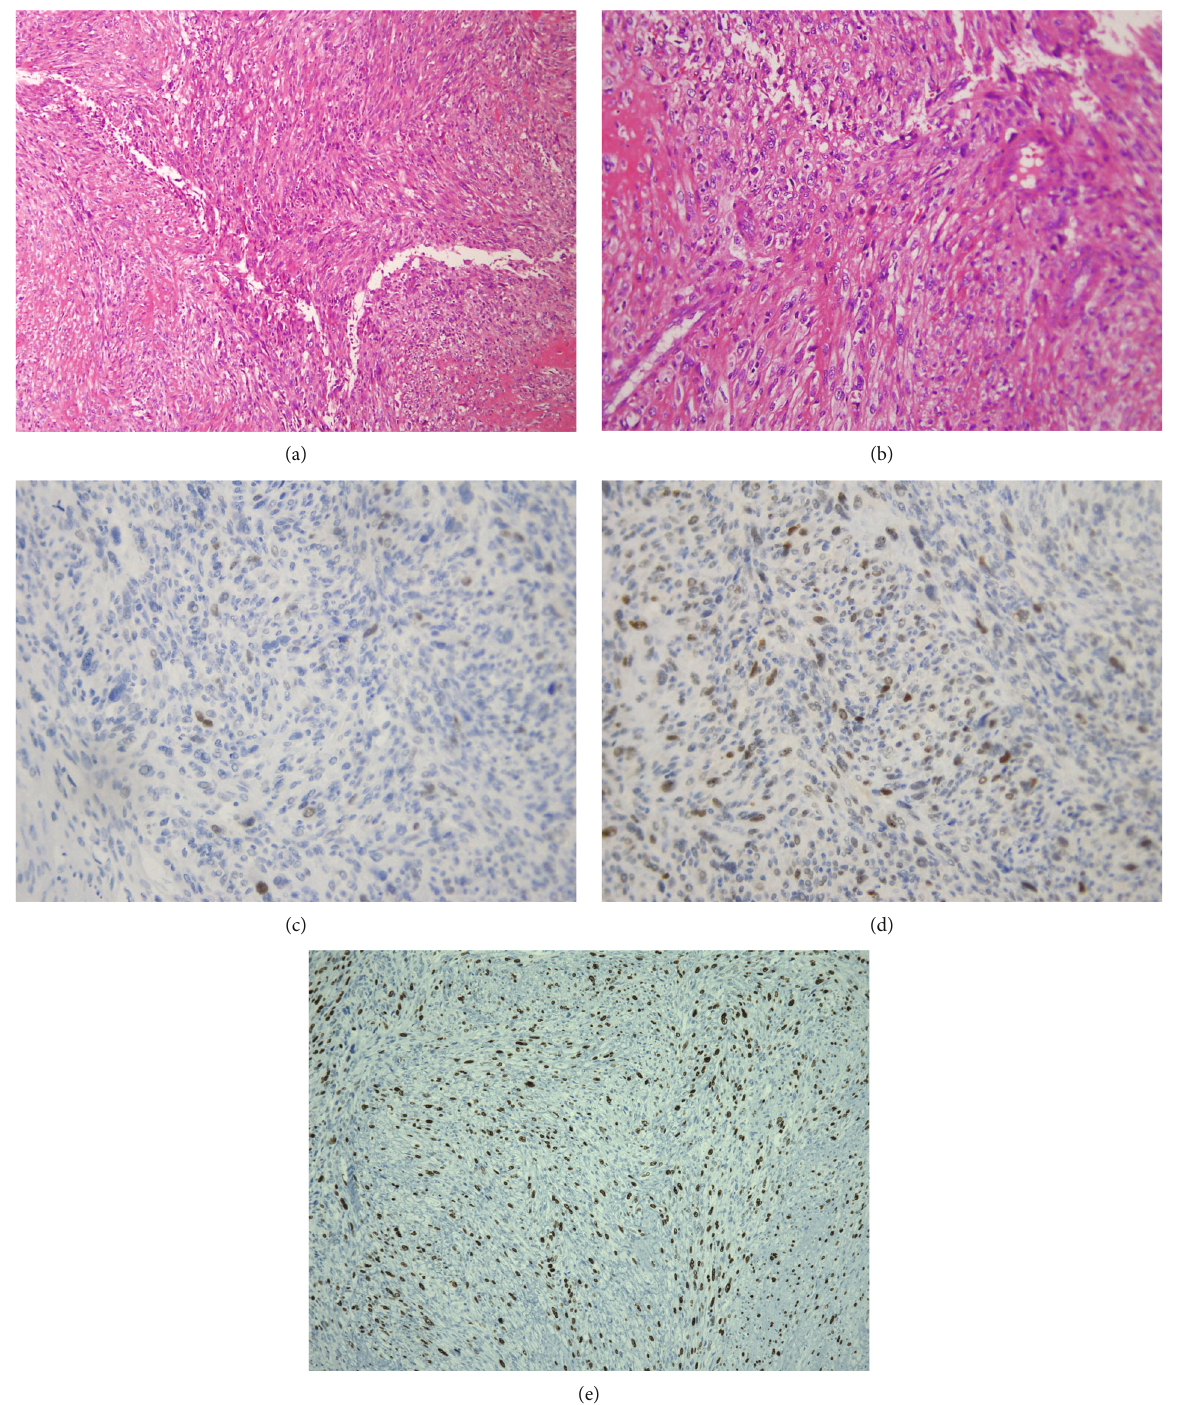
Figure 4: (a) Hematoxylin and eosin staining ( × 100). (b) Hematoxylin and eosin staining ( × 200). The spindle-like tumor cells appear to have formed thick fascicles with severe atypia around the tumor borders. The cells show more than 100 mitoses/50 high-power fi elds. There is no osteoid or necrotic tissue. (c) Immunohistochemical staining: positive results for CDK4. (d) Immunohistochemical staining: positive results for MDM2. (e) Immunohistochemical staining: Ki-67 index of 40% –